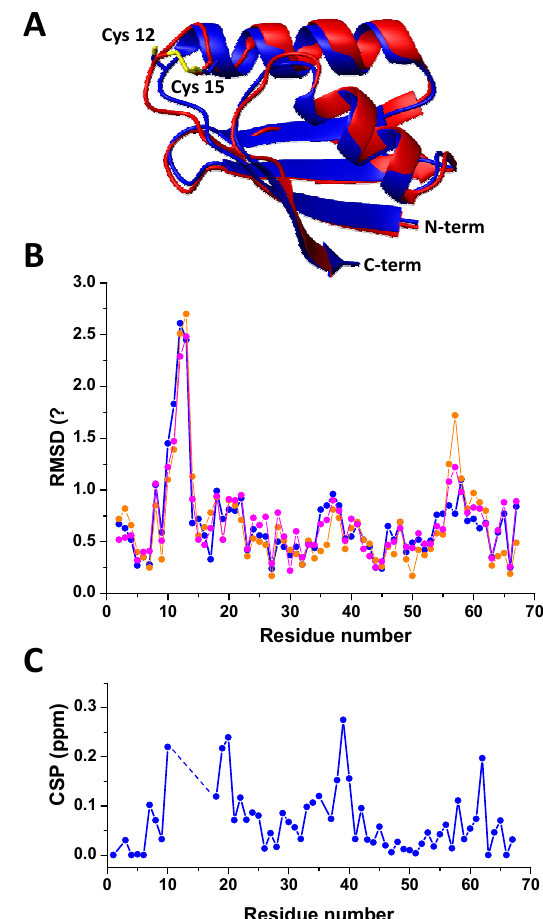
Figure 4. ( A ) Crystal structure of oxidized human Atox1 (red) overlaid on the structure of the monomeric human Atox1 with cisplatin (blue), used as molecular replacement model (PDB ID 3iwl). Sulfur atoms are shown in yellow. The cisplatin moiety is omitted for clarity. ( B ) Per-residue Cα root-mean-square deviation (RMSD) of oxidized human Atox1 with respect to monomeric human Atox1 with cisplatin (PDB ID 3iwl, blue line) and human Atox1 homodimer with oxaliplatin (4qot, orange line and magenta line for chains A and B, respectively). ( C ) Values of 1 H, 15 N chemical shift perturbation (CSP) between oxidized and reduced Atox1, plotted for each assigned amino acid.